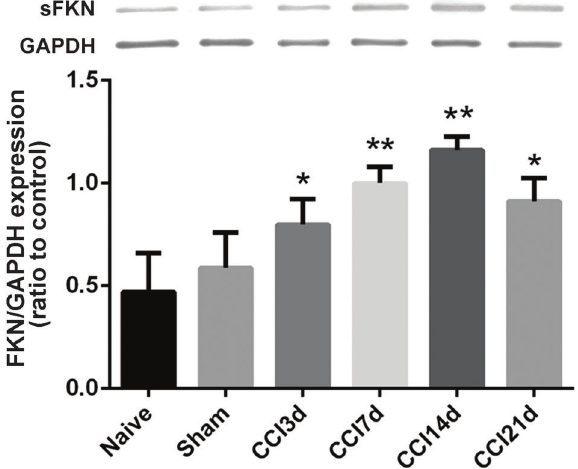
Figure 3. Fractalkine (FKN) mRNA expression was increased after chronic constriction injury (CCI) surgery. Real-time PCR was conducted with total RNA samples extracted from the CSF- contacting nucleus in naive, sham, and CCI rats on days 3, 7, 14, and 21. **P o 0.01 vs sham group, n=5, F=48.2 (one-way ANOVA, LSD test). CSF: cerebrospinal fl uid.